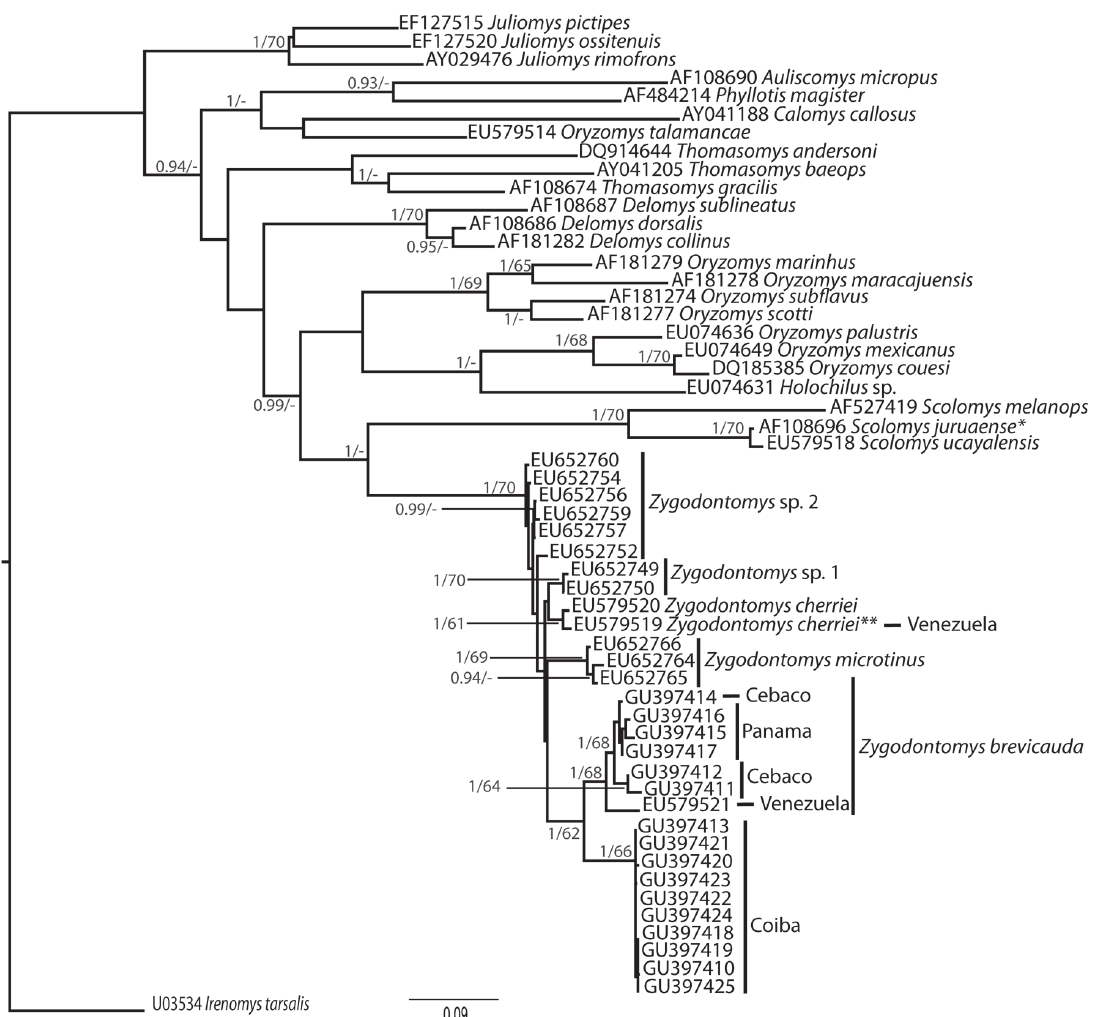
Figure 2. Phylogenetic relationship (maximum likelihood) for populations of Zygodontomys and from 28 other species representing 10 other sigmodontines rodent genera. Support values are the numbers on major branches reported as Bayesian posterior probability values/maximum likelihood bootstrap support values. * Scolomys juruaense is now considered S. ucayalensis . ** Source of sequence lists it as Z. brevicauda